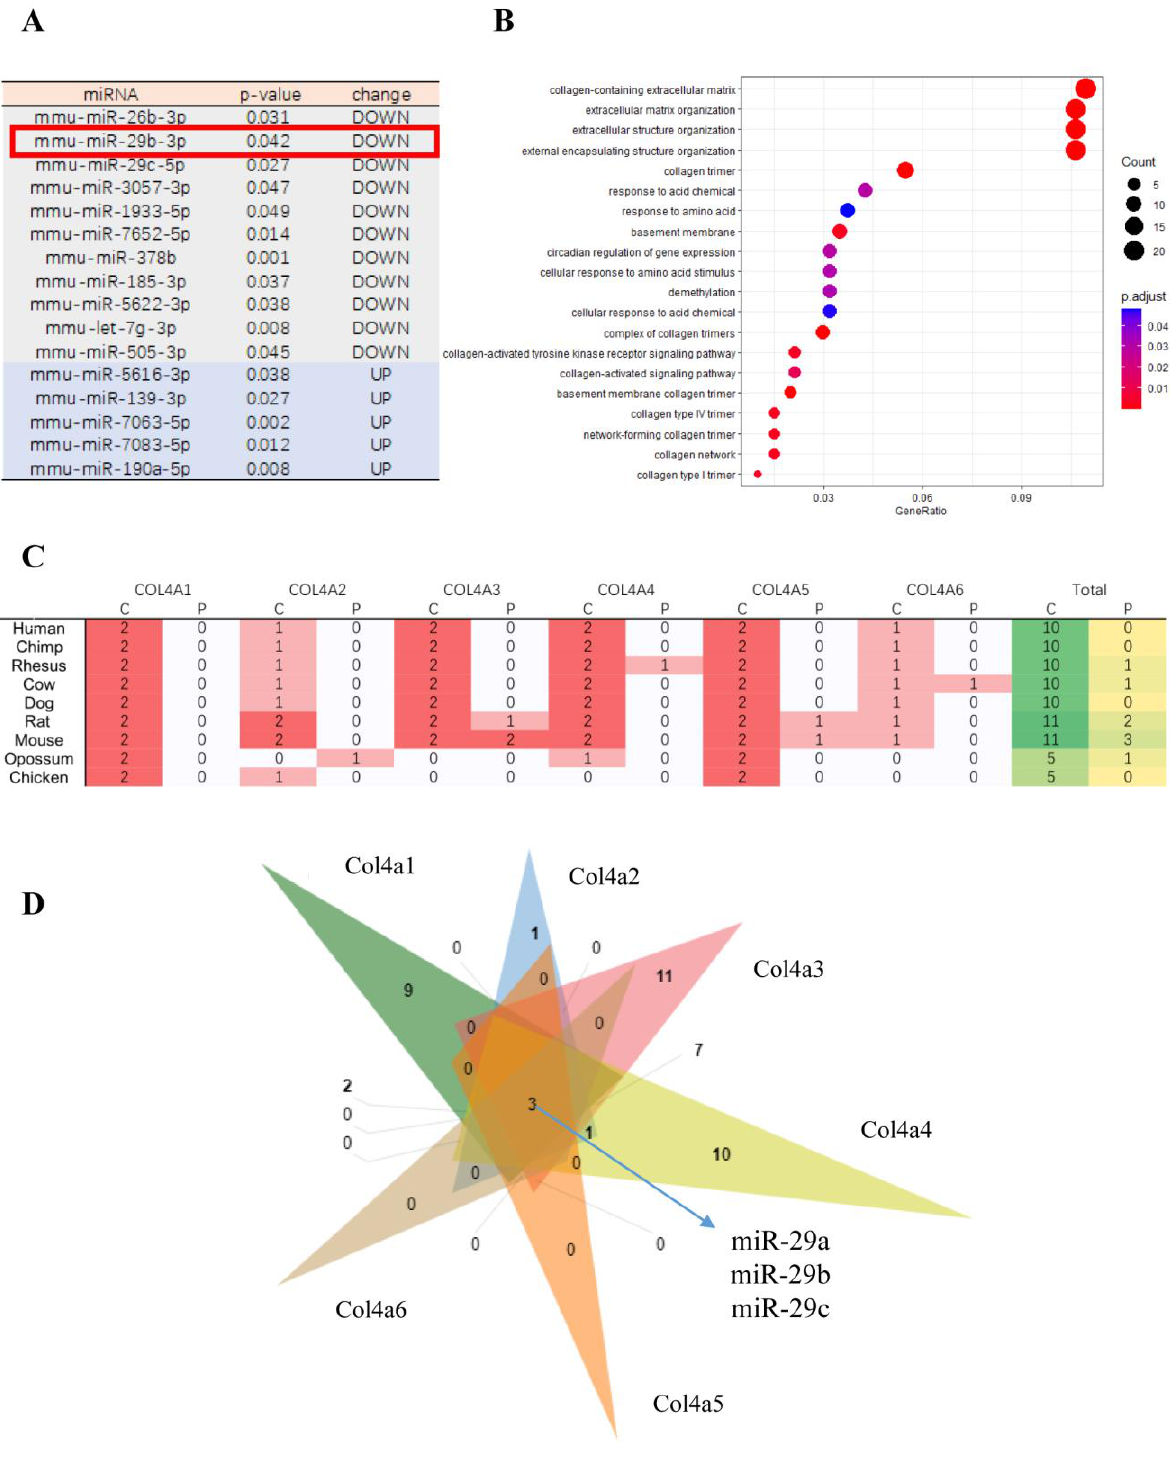
Figure 1. MiR-29 target genes analysis. ( A ) Significantly differentially expressed miRNAs after hypoxia treatment ( p < 0.05). ( B ) Top 20 significantly enriched GO functional categories. ( C ) Statistics on the number of binding sites in collagen IV subunits of different species. C: conserved site; P: poorly conserved site. ( D ) Venn diagram showing the overlapping miRNA among the miRNAs regulating Col4a1 to Col4a6 for mouse.